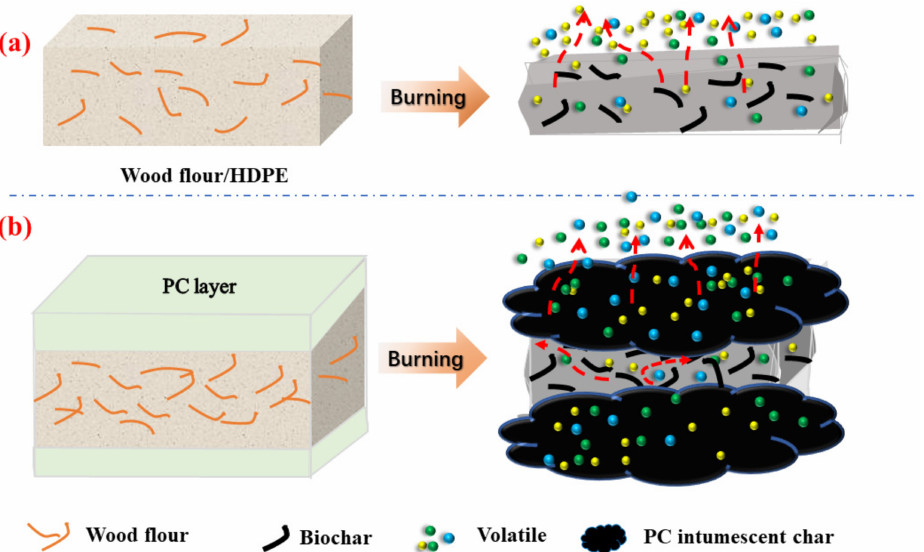
Figure 8. The schematic of smoke and flame suppression mechanism of single-layer ( a ) and multilay- ered WPCs ( b